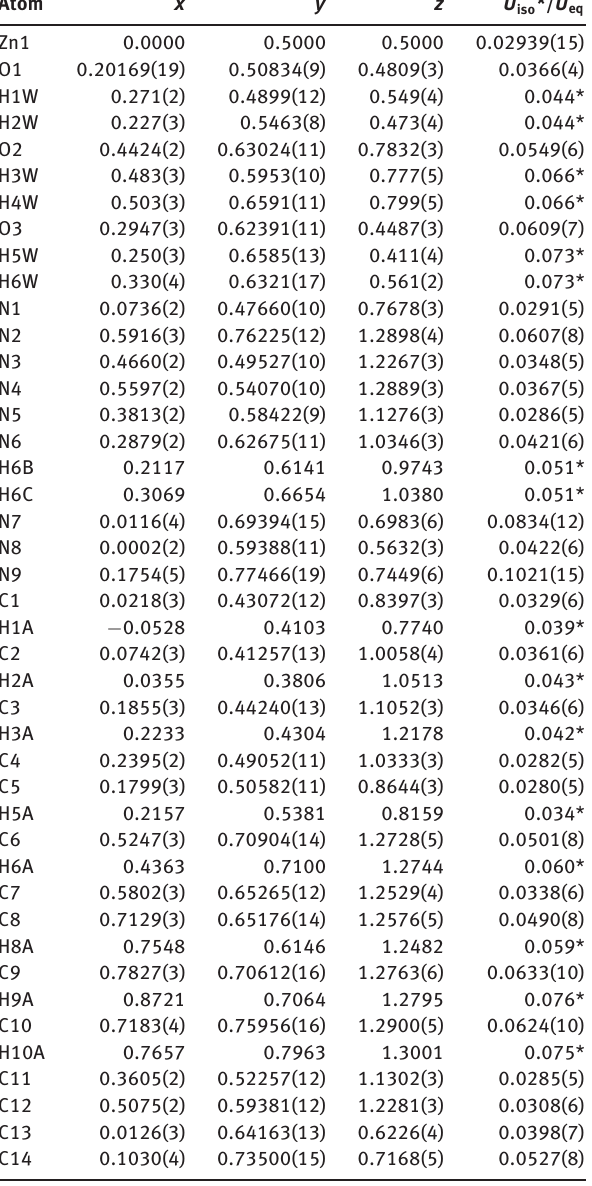
Table 2: Fractional atomic coordinates and isotropic or equivalent isotropic displacement parameters (Å 2